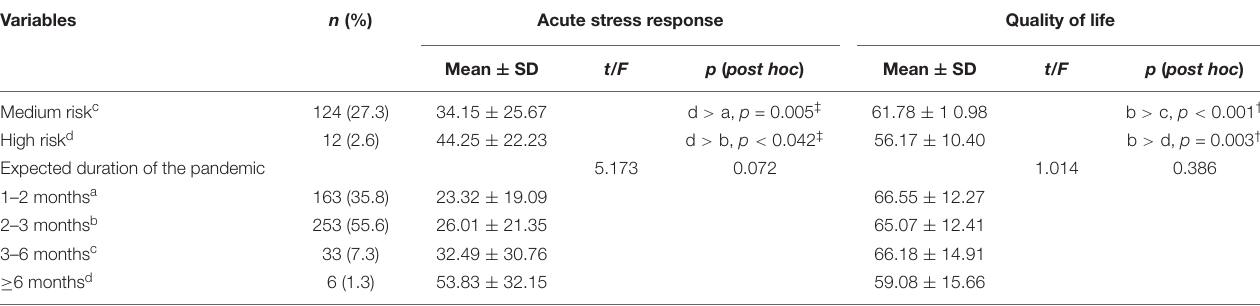
TABLE 2 | Correlation between acute stress response and quality of life.